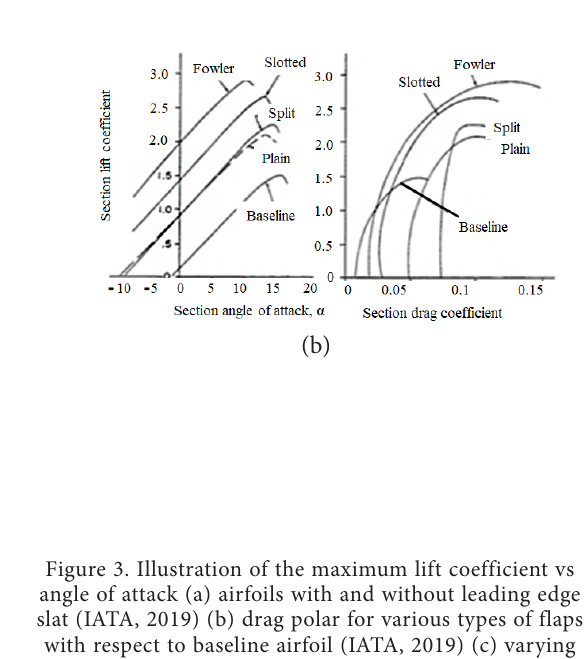
Figure 3. Illustration of the maximum lift coefficient vs angle of attack (a) airfoils with and without leading edge slat (IATA, 2019) (b) drag polar for various types of flaps with respect to baseline airfoil (IATA, 2019) (c) varying number of slots on aircraft wing